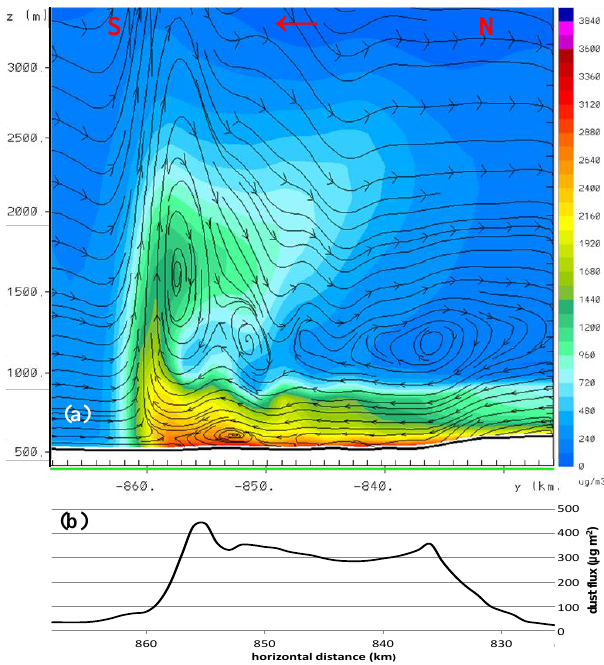
Fig. 9. (a) Dust concentration (color scale inµgm − 3 ) and stream- lines at 18:50UTC for a reference frame relative to the propagating speed. The location of the cross section is at x = − 898. The direc- tion of the motion is from North to South as illustrated with the red arrow on top of the figure. (b) Dust flux (µgm − 2 /model timestep) at each model grid point along the same cross section.